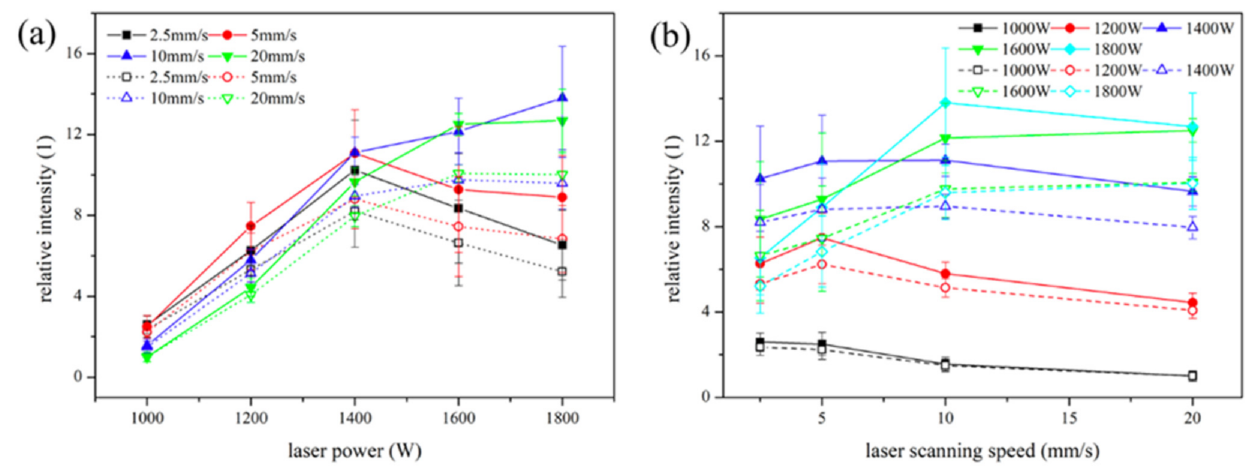
Figure 35. The correlation between relative mean intensity of spectral lines and laser parameters (solid points: Cr I, empty points: Fe I), ( a ) relative mean intensity and laser power, ( b ) relative mean intensity and laser scanning speed